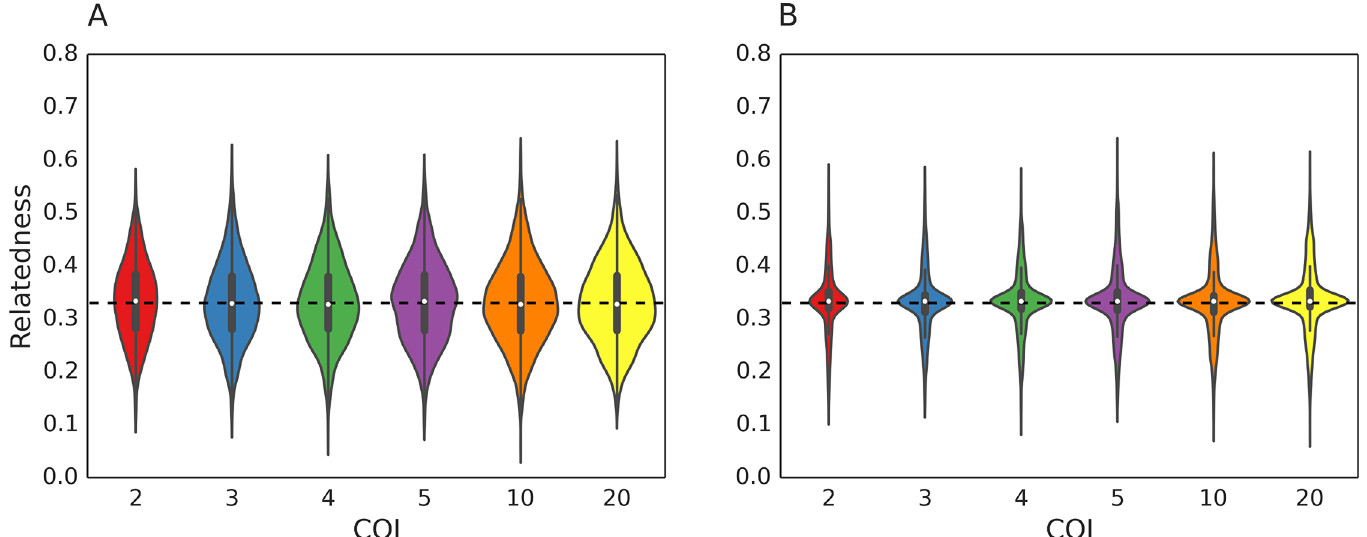
Fig 4. Relatedness of cotransmitted strains when oocyst count is 1. Violin plots of the relatedness of cotransmitted strains in single oocyst simulations. Only the results for simulations with infected hepatocyte count of 2 ( A ) or 5 ( B ) are shown. The expected relatedness (in terms of both median and mean) is always 0.33. A box plot is drawn in the center of each violin plot, where the white dot represents the median of the distribution, the thicker line represent the interquartile range, and the thinner line represents the whiskers of the box plot, up to 1.5 times the interquartile range. The horizontal dotted line represents the value of 0.33.